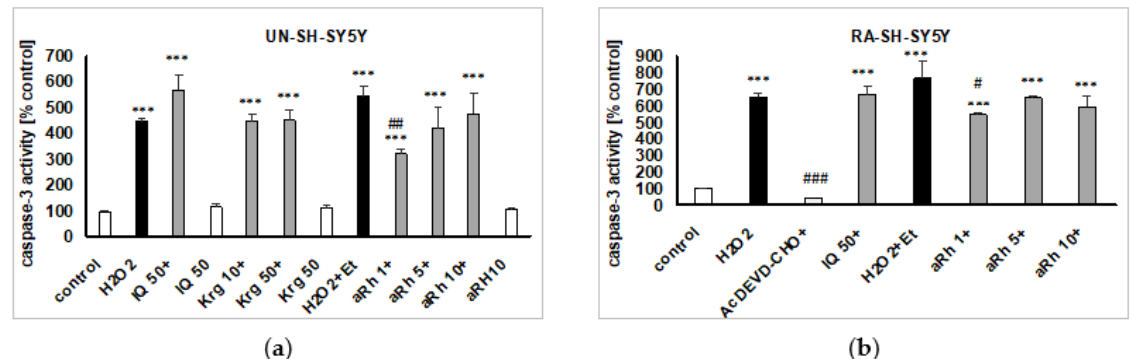
Figure 6. The effects of the tested flavonols against hydrogen peroxide (H 2 O 2 )-induced caspase-3 activity in ( a ) UN- and ( b ) RA-SH-SY5Y cells. The cells were pre-treated for 30 min with isoquercitrin (IQ, 50 µ M), kaempferitrin (Krg, 10 and 50 µ M) and α -rhamnoisorobin (aRh, 1–10 µ M) followed by 9 (UN-) or 18 h (RA-) exposure to H 2 O 2 (0.375 and 0.5 mM for UN- and RA-SH-SY5Y, respectively). Caspase-3 inhibitor Ac-DEVD-CHO (10 µ M) was used as a positive control for the assay. Data were normalized to the vehicle-treated cells and are presented as the mean ± SEM. The data were analyzed by one-way ANOVA. *** p < 0.001 vs. the vehicle-treated cells; # p < 0.05, ## p < 0.01 and ### p < 0.001 vs. the H 2 O 2 + Et-treated cells.